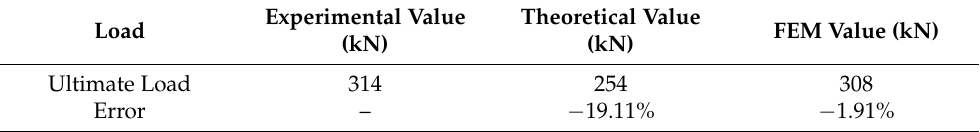
Table 6. Ultimate load of the hollow